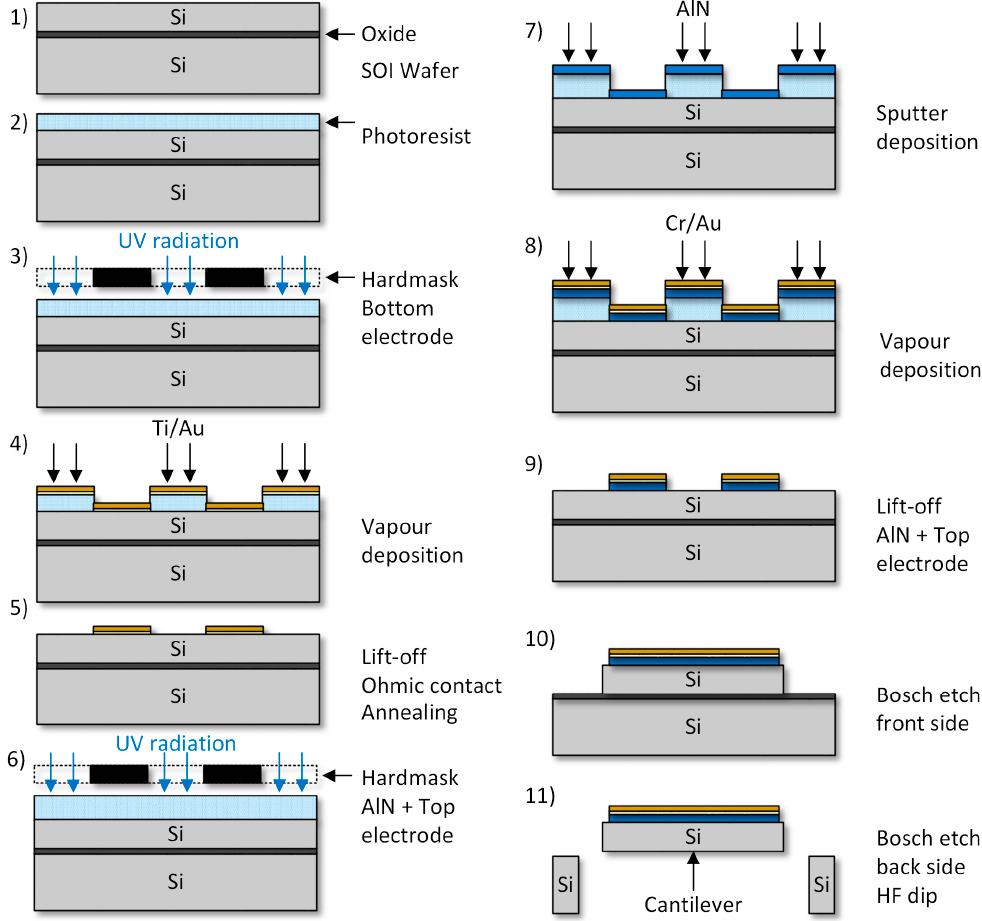
Figure 1. Schematics of the fabrication process.